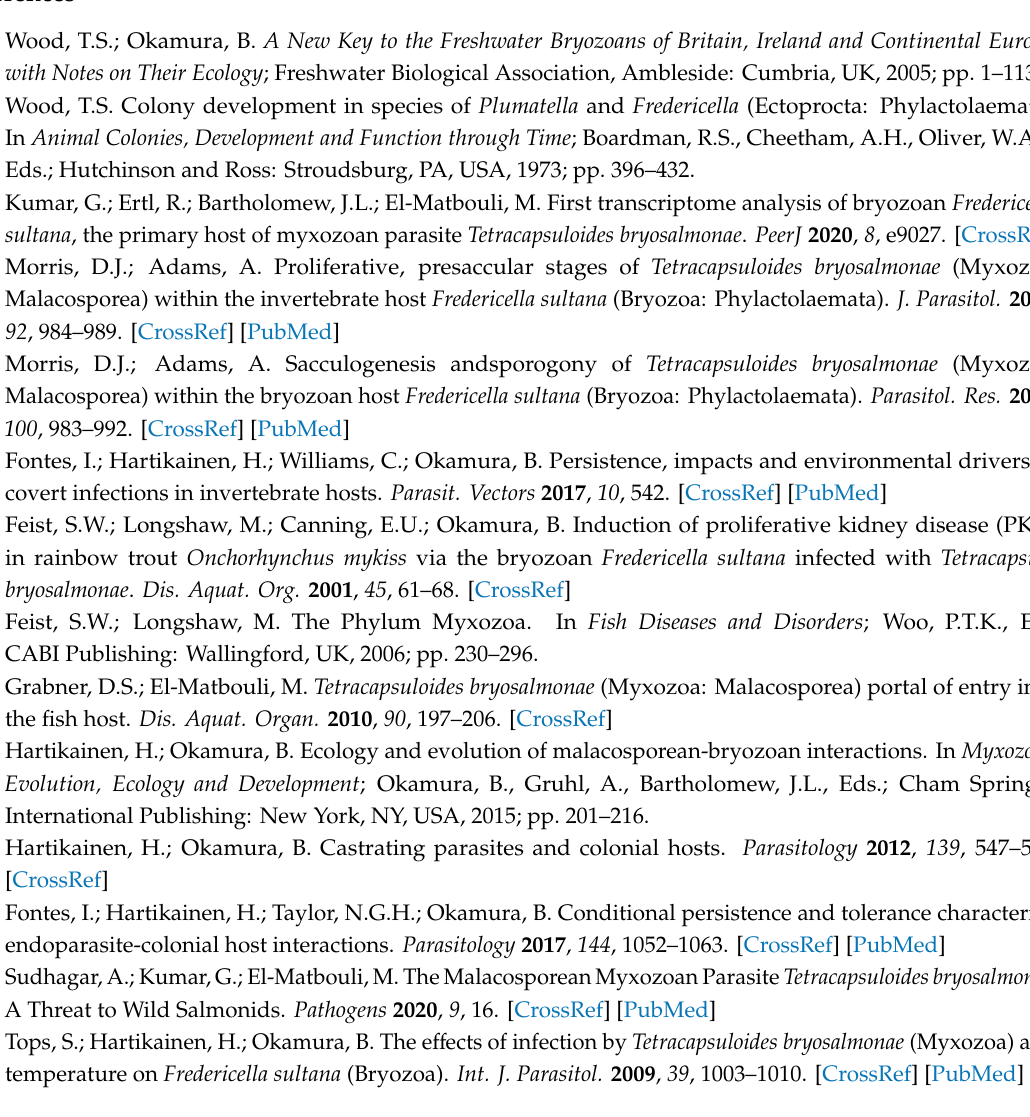
List of enriched canonical pathways, Table S4: List of predicted upstream regulators, Table S5: Enriched gene ontology terms of all di ff erentially upregulated genes of infected zooids, Table S6: List of quantitative real-time PCR